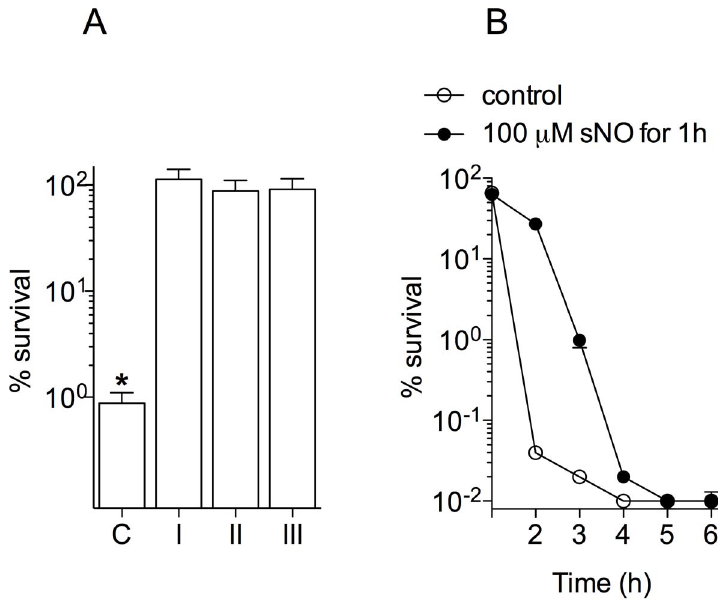
Figure 2. NO tolerizes B.pseudomallei to the antimicrobial activity of imipenem. (A) All bacteria in groups I-III were treated with 25 m g/ml imipenem for 2.5 h. B. pseudomallei in group I were treated with 100 m M spermine NONOate (sNO) 1 h after exposure to imipenem; sNO was removed from group II after 1 h of treatment; sNO was maintained in group III during the 2.5 h of challenge. The survival of control bacteria (C) treated with 25 m g/ml of imipenem is shown for comparison. Panel B shows the fraction of B. pseudomallei that survived 25 m g/ml imipenem at the indicated times. Selected specimens (dark symbols) were treated with 100 m M sNO during the first hour of exposure to imipenem. The data are the mean 6 SEM from 5 observations collected on 2 separate days. p , 0.001 compared to groups